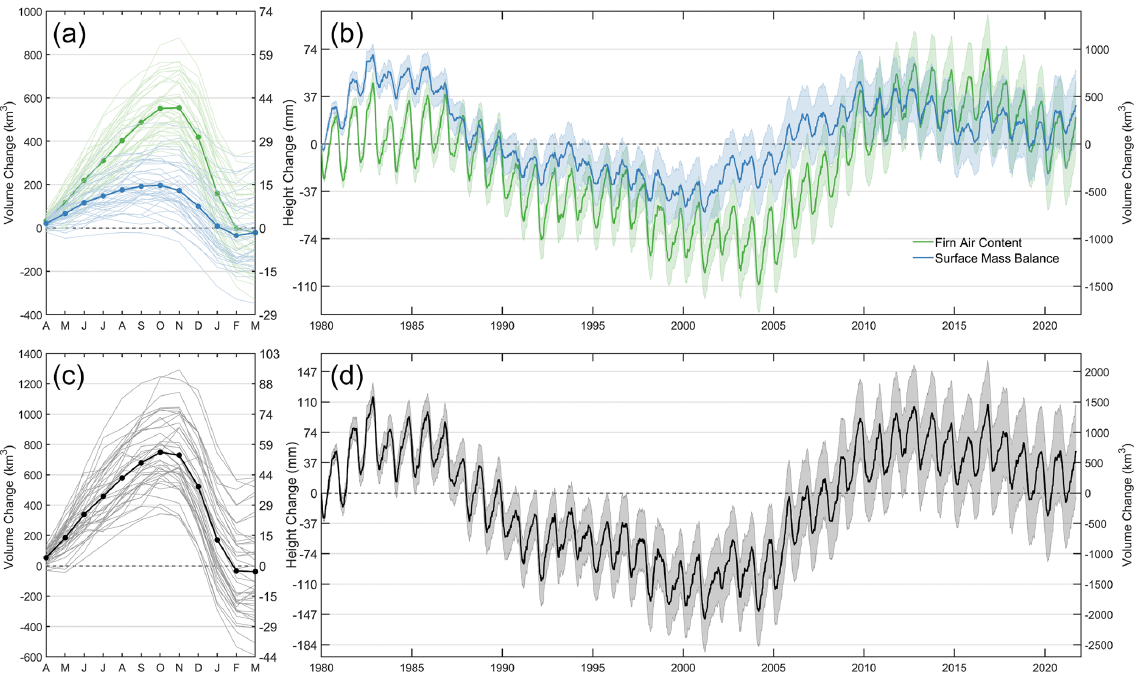
Figure 18. Height and volume change of the Antarctic Ice Sheet (grounded and floating ice). (a) Seasonal changes separated into surface mass balance (SMB; blue) and firn air content (FAC; green) components. The thin lines represent each year, and the thick, dotted line represents the mean over the RCI (1980–2019). (b) A 40-year time series of volume and height change due to SMB and FAC. (c, d) The FAC and SMB combined height and volume change. The shaded regions represent the cumulative 2 σ uncertainty in the volume changes, which accounts for spatial and temporal correlation in the time series. Note the differences in scale. Table 2. Modeled GrIS SMB performance statistics against N = 312 observations (see Sect. 2.5.2 for description), which are plotted in Fig. 20. The final column presents a comparison ( N = 1688416) between the ensemble mean annual SMB from GrSMBMIP and the GSFC mean annual SMB interpolated onto the GrSMBMIP grid that is mapped in Fig. 21. N is the total number of observations used in the model comparison, µ is the mean of the observations, σ is the standard deviation, MB is the mean bias (GSFC minus observation), RMSE is the root mean square error, and r is the correlation